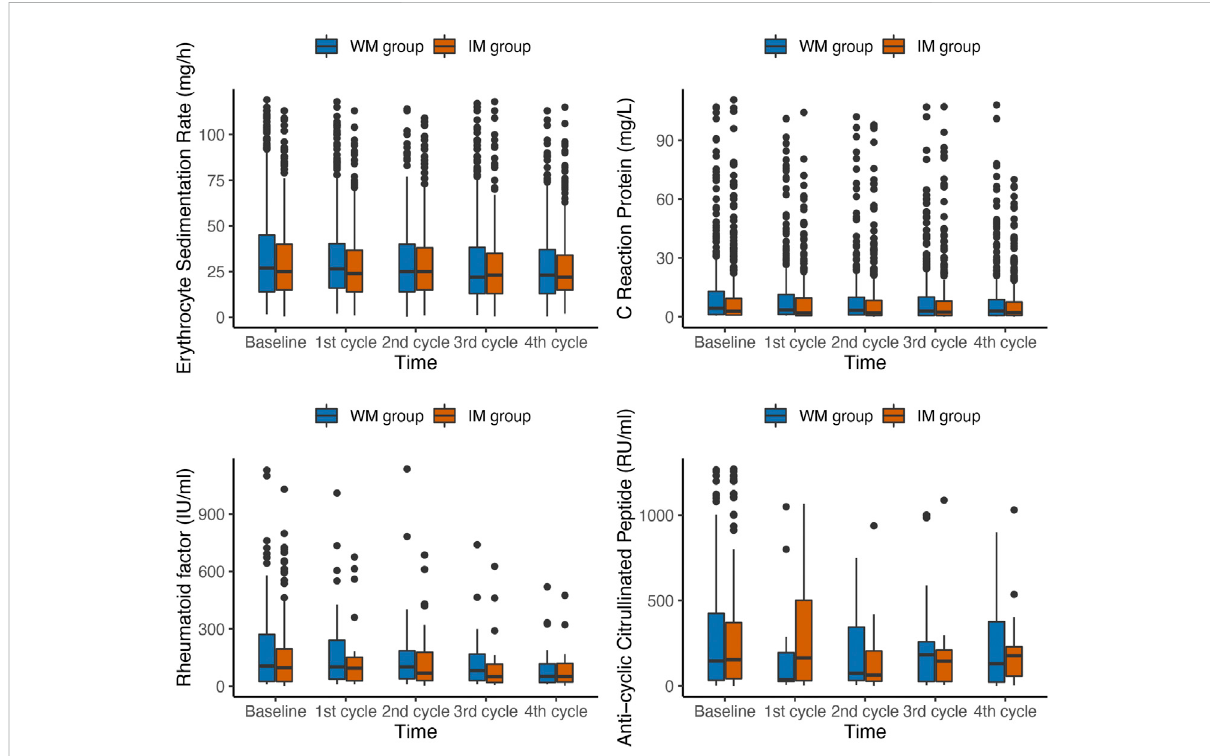
FIGURE 3 Box plots of changes in laboratory outcomes during the fi rst year of follow-up in PP population. IM: Integrative medicine, WM: Western medicine, PGA, PhGA, patient ’ s and doctor ’ s global assessment of disease activity based on visual analogue